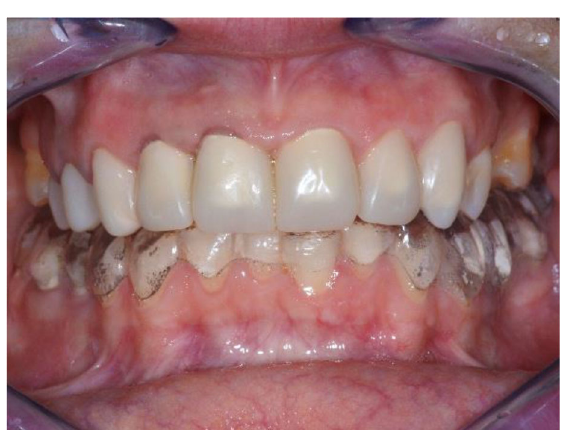
Figure 17. Splint in the patient ’ s mouth.